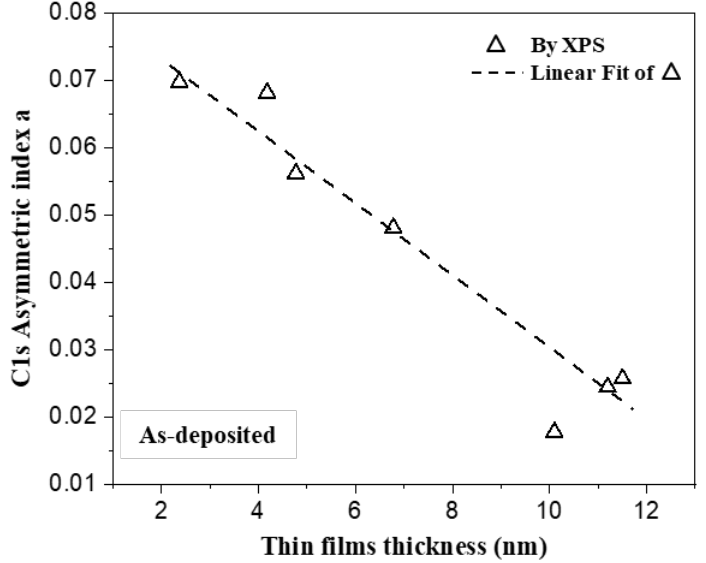
Figure 6. Thickness of as-prepared C 32 H 66 thin film effects on the C1s asymmetric index.